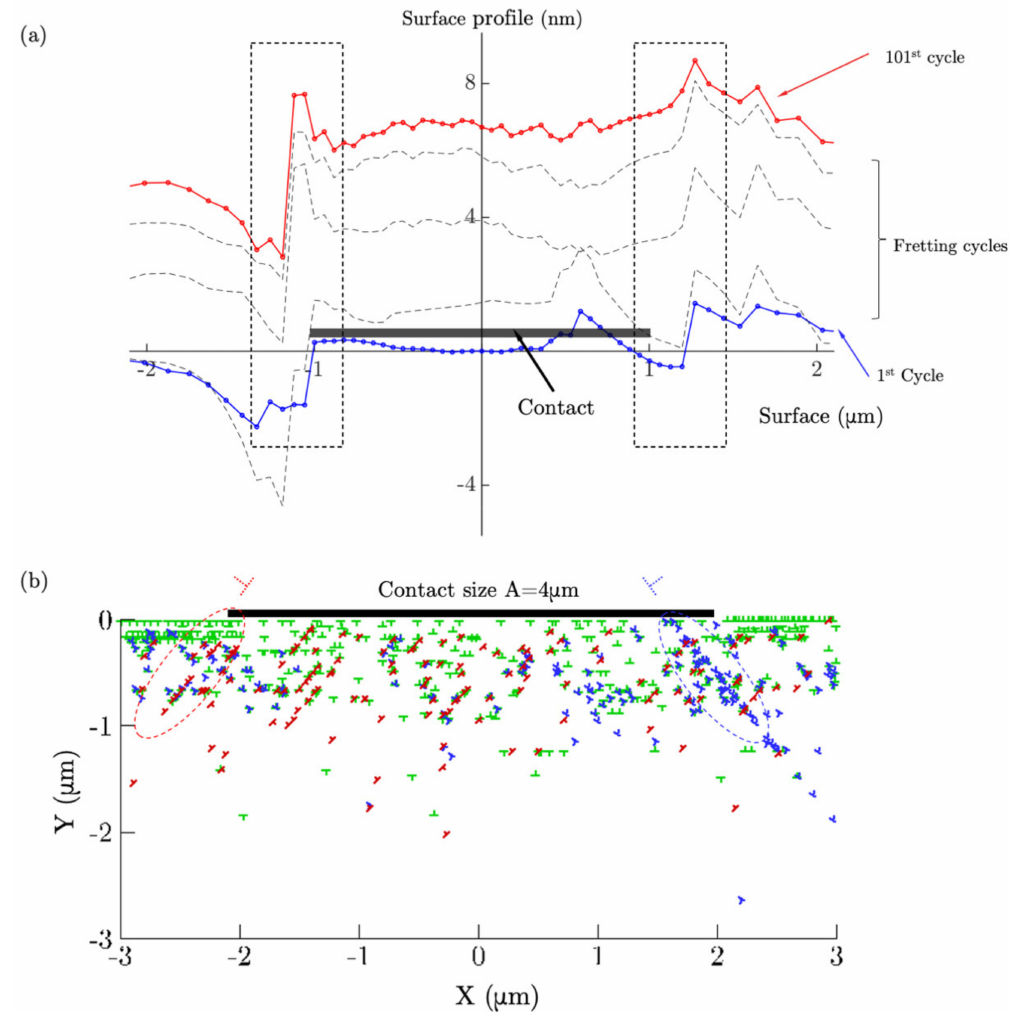
Figure 3. ( a ) The surface profile along the contact surface (the contact length was set as A = 2.0 µ m) after 100 cycles without a preceding indentation. ( b ) The instantaneous dislocation structure after 50 cycles for contact size A = 4.0 µ